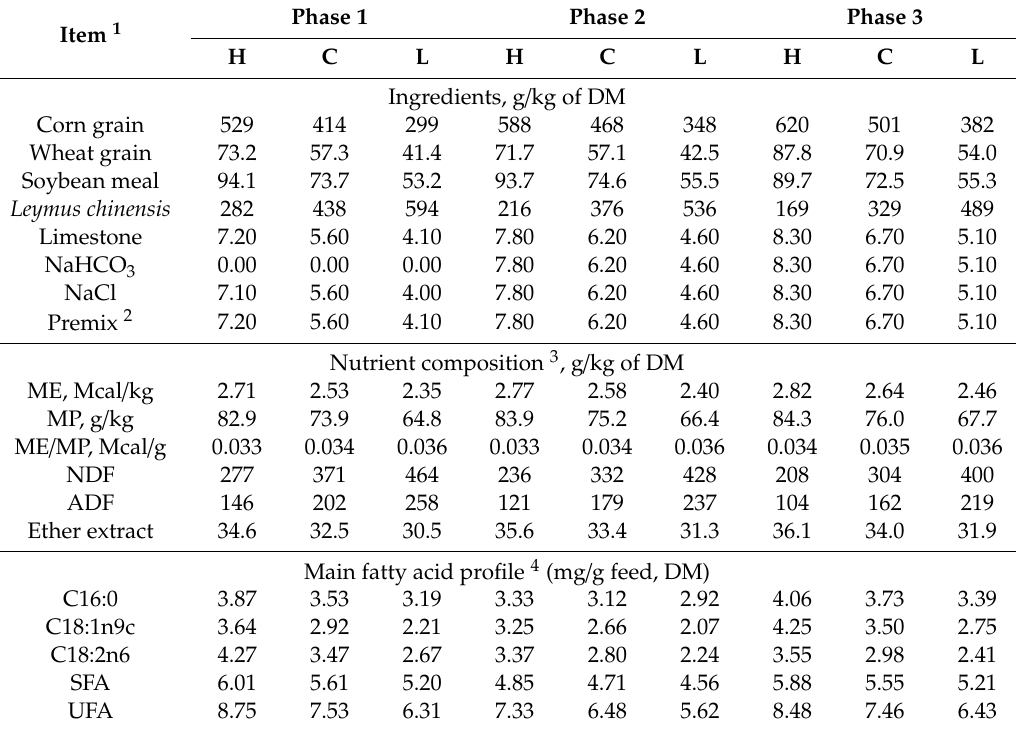
Table 1. Ingredients and nutrient compositions of the